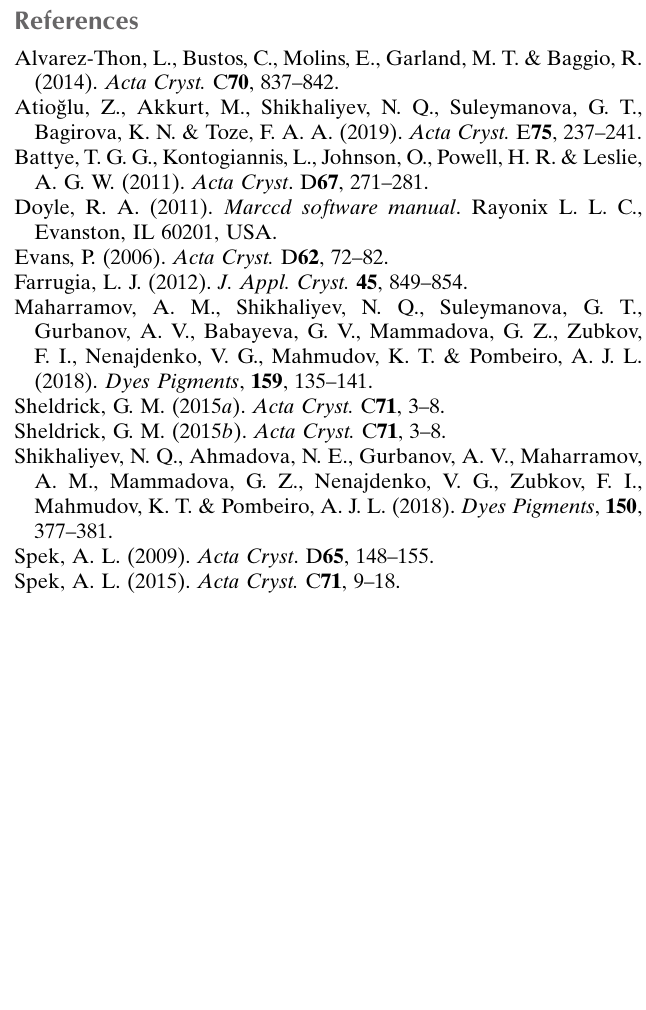
Table 2 Experimental details. Crystal data Chemical